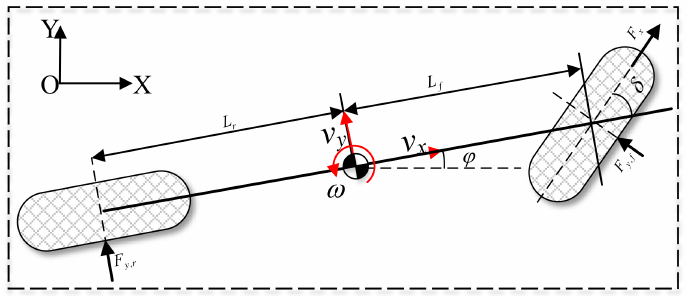
Figure 1. The 3DOF vehicle dynamics